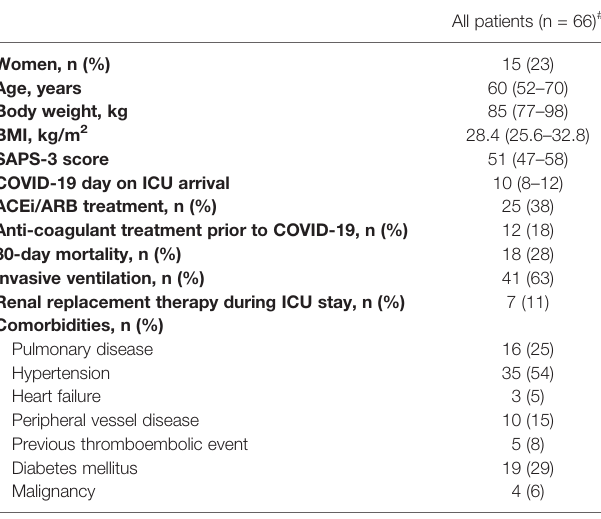
TABLE 1 | Patient demographic characteristics and